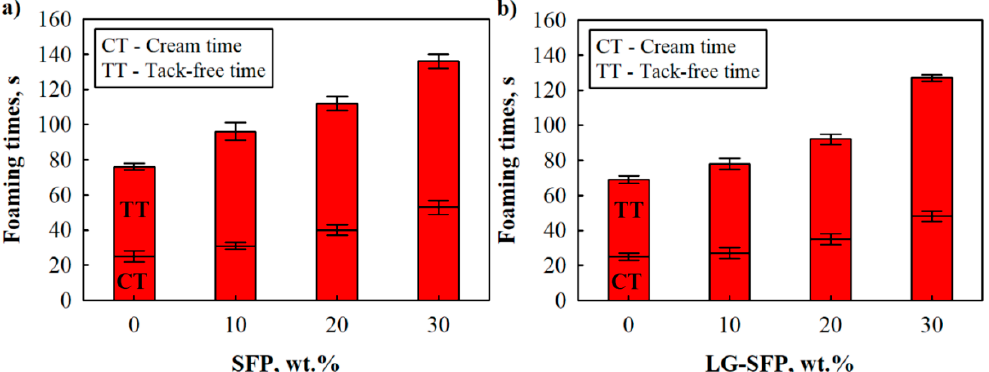
Figure 3. Foaming times of unmodified, SFP, and LG-SFP modified PUR foam mixtures: ( a ) SFP and ( b ) LG-SFP.